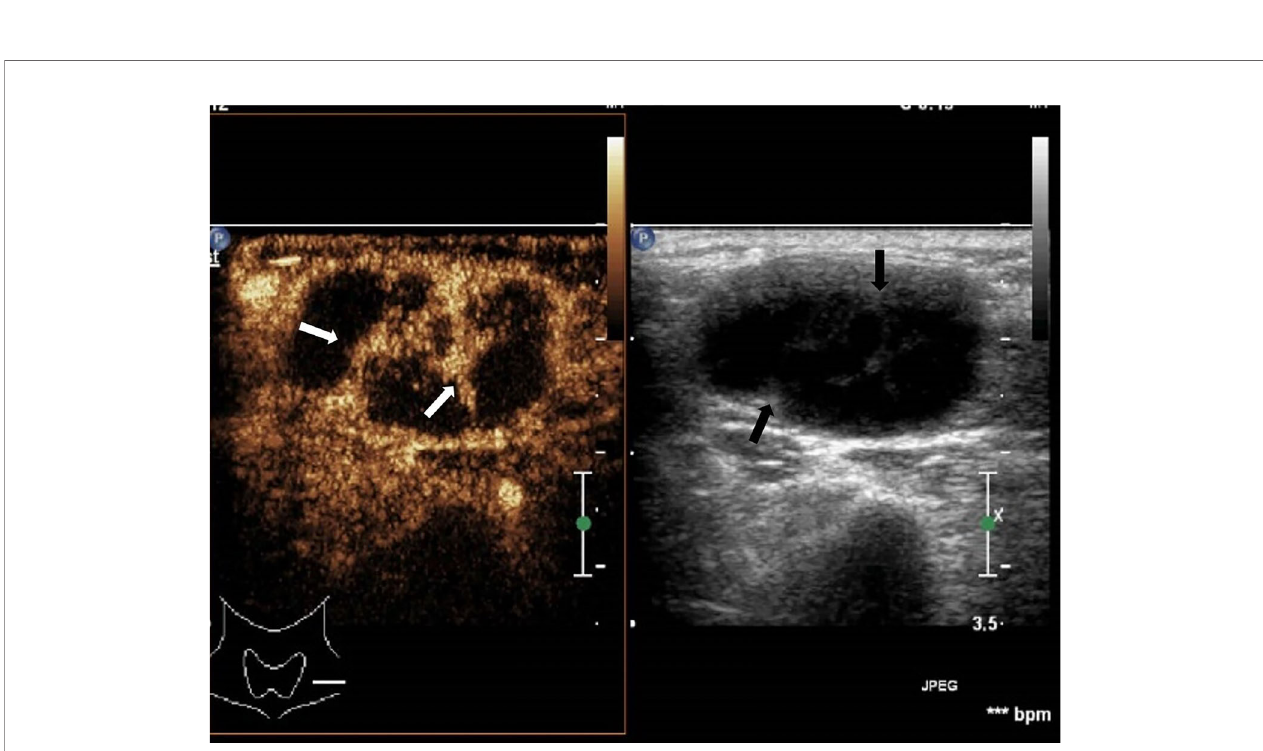
FIGURE 3 | Cervical tuberculous lymphadenitis: lymph node enlargement, absent hilum, honeycomb-like hypoechoic is not signi fi cant (black arrow), but CEUS can clearly show enhancement (white arrow).